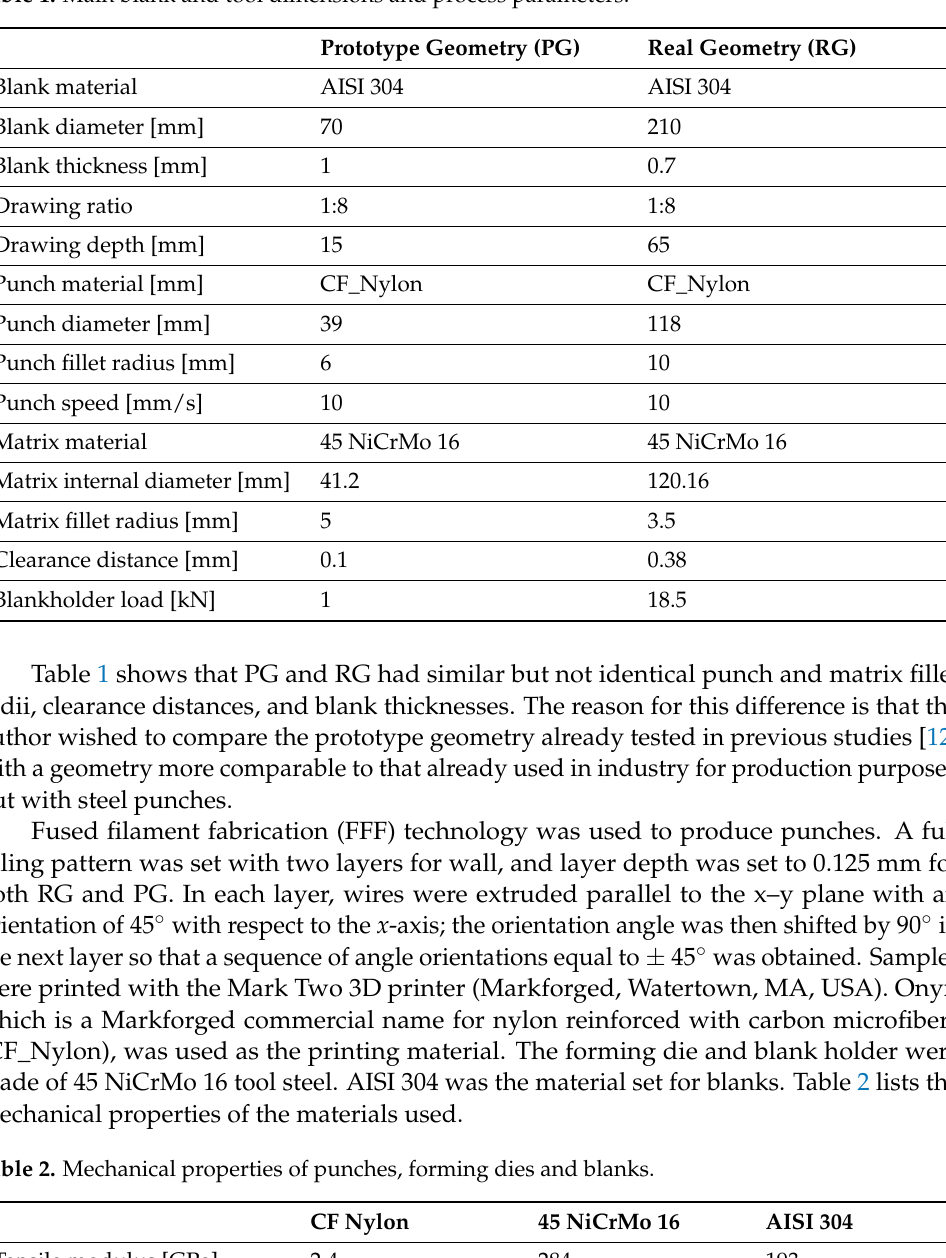
Table 1. Main blank and tool dimensions and process parameters.